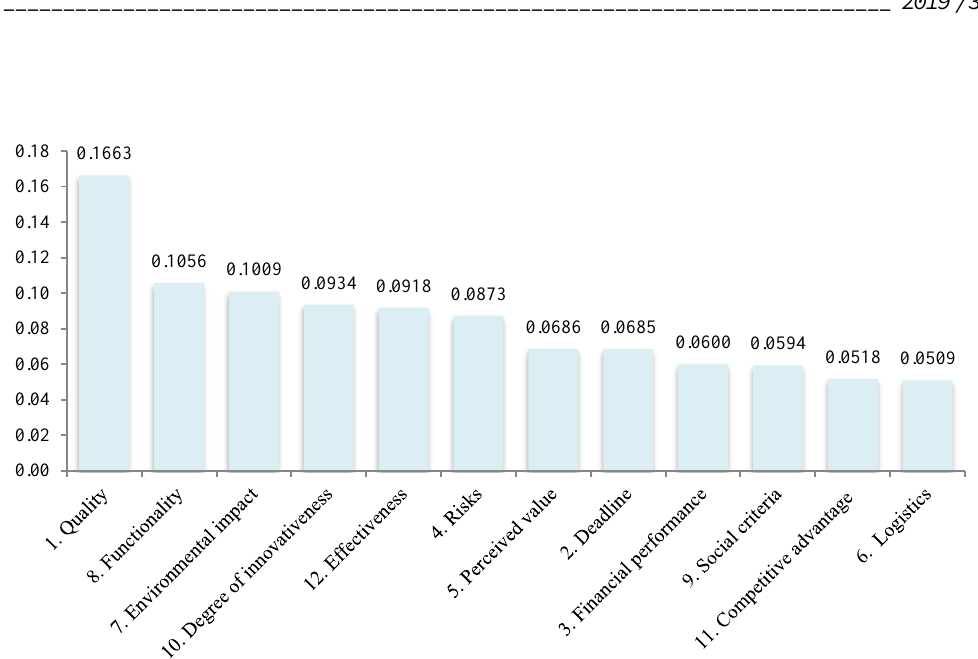
Fig. 3. Innovation evaluation criteria weight (created by the